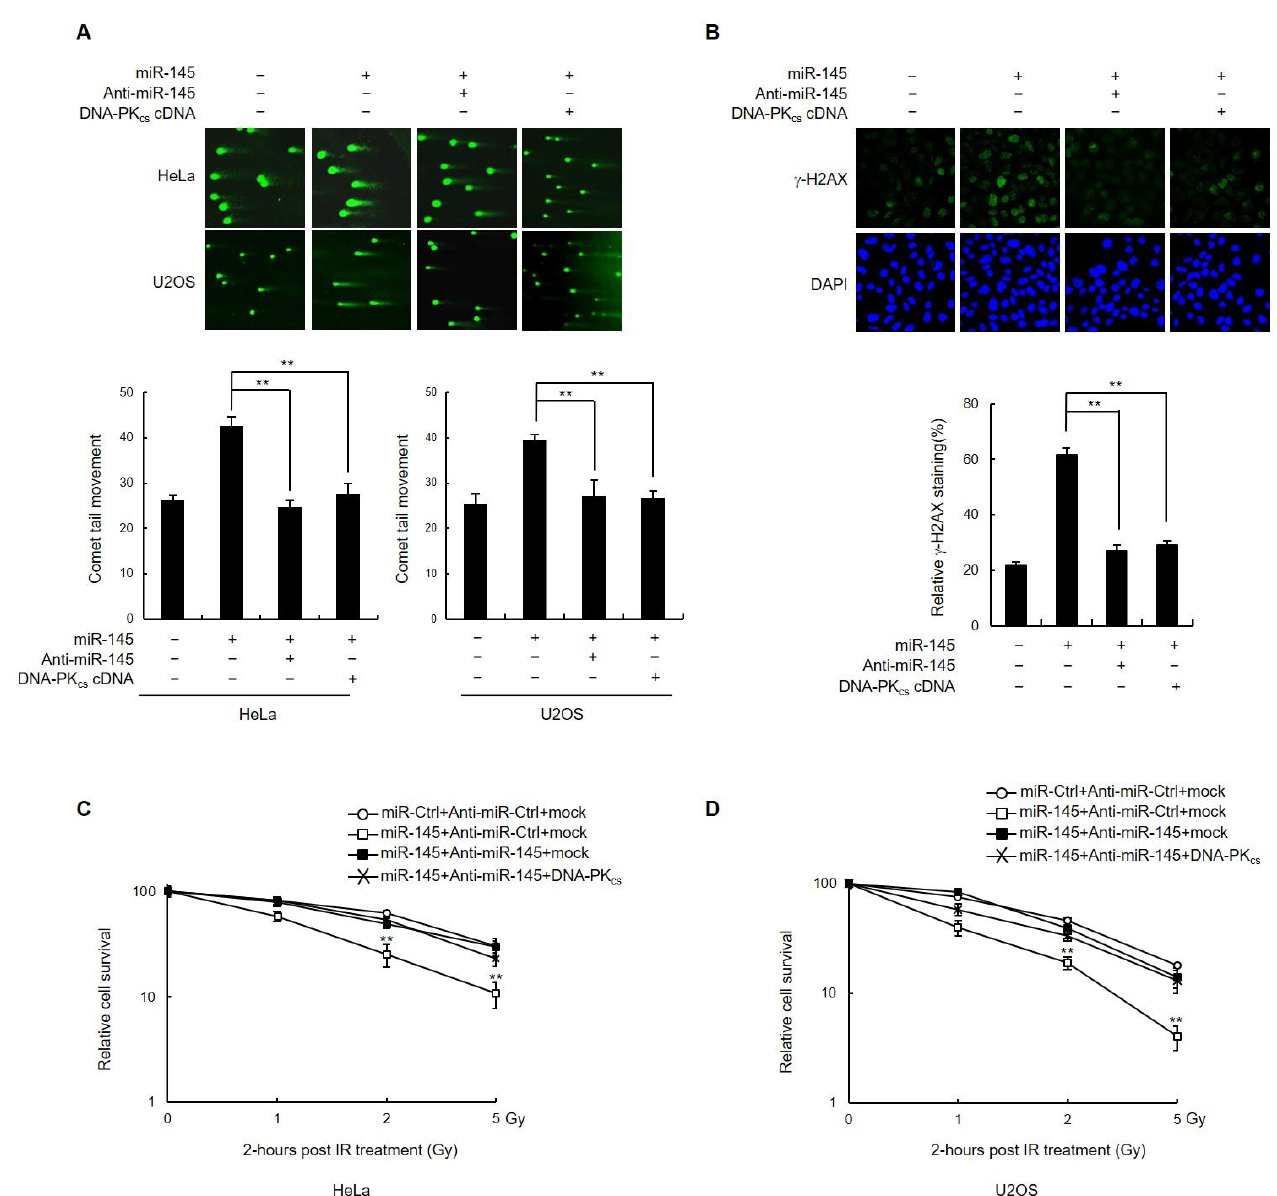
Figure 4. Expression of anti-miR-145 or miR-145-insensitive DNA-PK cs cDNA rescues DNA repair defect and radiosensitivity. ( A ) HeLa and U2OS cells were co-transfected with combinations of miR-145, miR-Ctrl, anti-miR-145, or DNA-PK cs cDNA as indicated. Three hours after γ -ray irradiation with 10 Gy, the cells were subjected to the neutral comet assay. Representative images (top) and quantification (bottom) of comet tail moment are shown. ( B ) HeLa cells co-transfected with either miR-145 or miR-Ctrl, as well as either anti-miR-145 or DNA-PK cs cDNA, were γ -ray irradiated with 10 Gy and subjected to immunofluorescence staining for γ -H2AX at the 20 h time point. ( C , D ) HeLa ( C ) and U2OS ( D ) cells co-transfected with combinations of miR-145, miR-Ctrl, anti-miR-145, or DNA-PK cs cDNA were γ -ray irradiated at the indicated doses, cultured for 2–3 weeks, and subjected to the clonogenic survival assay. In all panels, mean ± SD is shown. **, p < 0.01 versus control